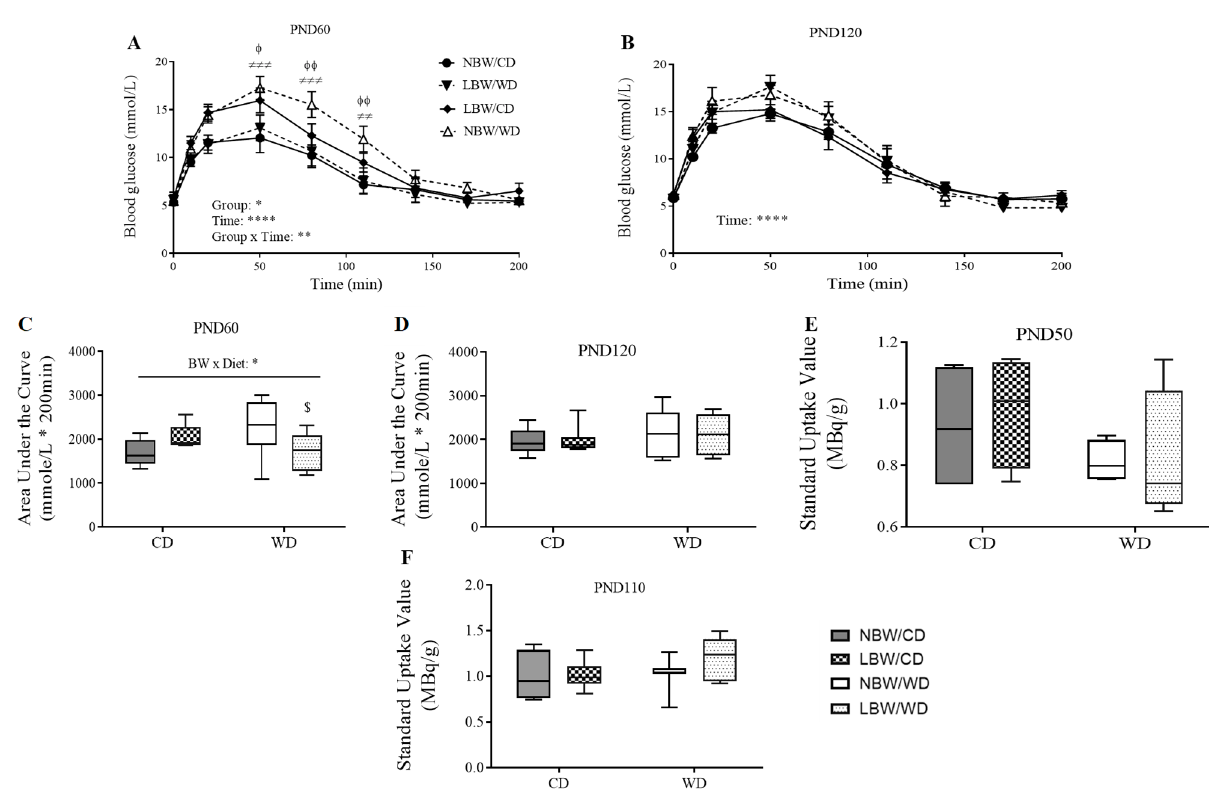
Figure 6. Whole-body glucose tolerance and skeletal muscle glucose uptake. Blood glucose at PND60 ( A ) and PND120 ( B ) was measured after an overnight (16 h) fast and at specific time points for 200 min following an intraperitoneal injection of 1 g/kg of 50% dextrose solution. The area under the glucose curve (AUC) as an index of whole-body glucose excursion after glucose loading at postnatal day (PND) 60 ( C ) and PND120 ( D ). Standard uptake value (SUV) = image-derived radioactivity/(injected activity/body weight) at PND50 ( E ) and PND110 ( F ) are presented. Data presented are the mean ± standard error (SEM) or min. to max. box and whisker plots for n = 4–12 animals/experimental group. Two-way repeated-measures ANOVA showed that the main effects of experimental group, time, and the time × experimental group interaction: * p < 0.05; ** p < 0.01; **** p < 0.0001. ϕ p < 0.05 and ϕϕ p < 0.01 for the difference between NBW/CD and LBW/CD offspring and ≠≠ p < 0.01; ≠≠≠ p < 0.001 for the difference between NBW/CD and NBW/WD offspring following a Bonferroni post hoc test. BW × Diet: * for p < 0.05 for the main effect of birth weight (BW) and diet interaction using a regular two-way ANOVA. $ p < 0.05 for the difference between NBW/WD and LBW/WD after a Bonferroni post hoc test following a regular two-way ANOVA.